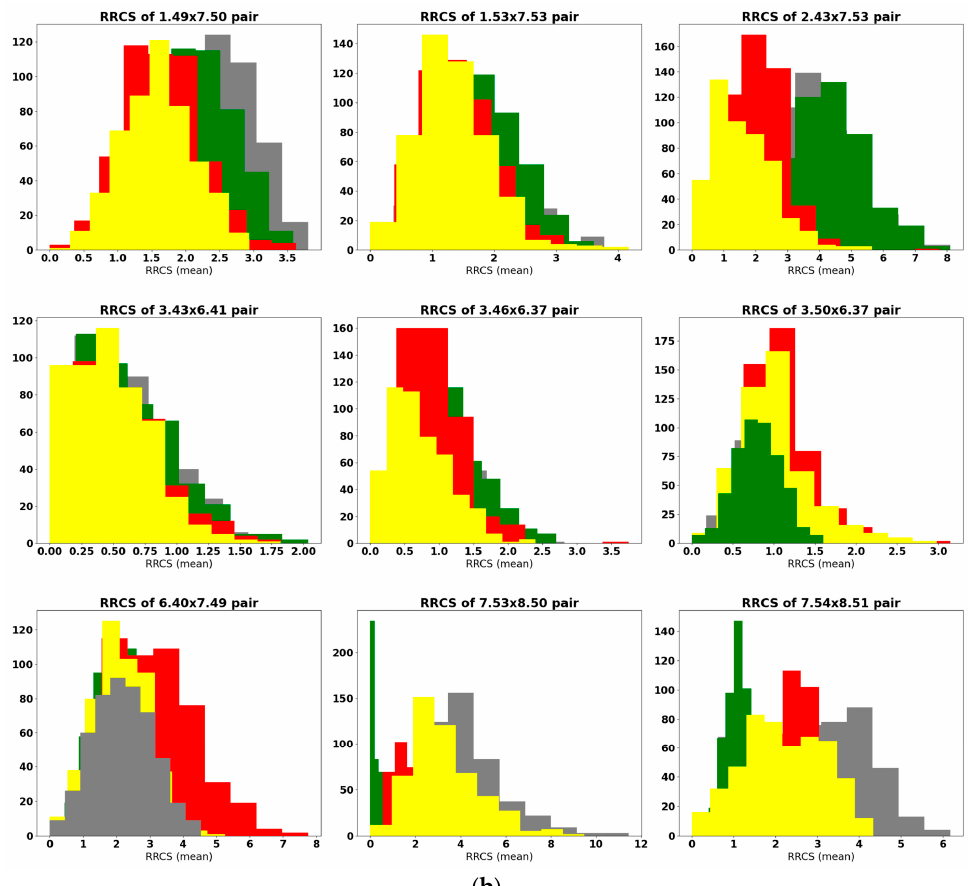
Figure 11. ( a , b ) Histograms of residue–residue contact scores (RRCSs) calculated for 1 frame/1 ns of 500 ns MD simulation (average of 3 trajectories) of insect mAChR-A Apo receptor (in grey). Contacts that increase ( a ) and decrease ( b ) RRCS upon activation by a ligand are shown for muscarine in green, IR3535 in red, and for BQCA-azo-IR3535 in yellow. A comparison of data presented in Figures S7a,b, and 11a,b may reveal possible dif- ferences in structural effects exerted by our bitopic ligand on human and insect recep- tors, respectively. Similar to human M1 GPRC, the bitopic ligand does not strikingly strengthen the mAChR-A contacts in the signaling pathway pairs (Figure 11a).